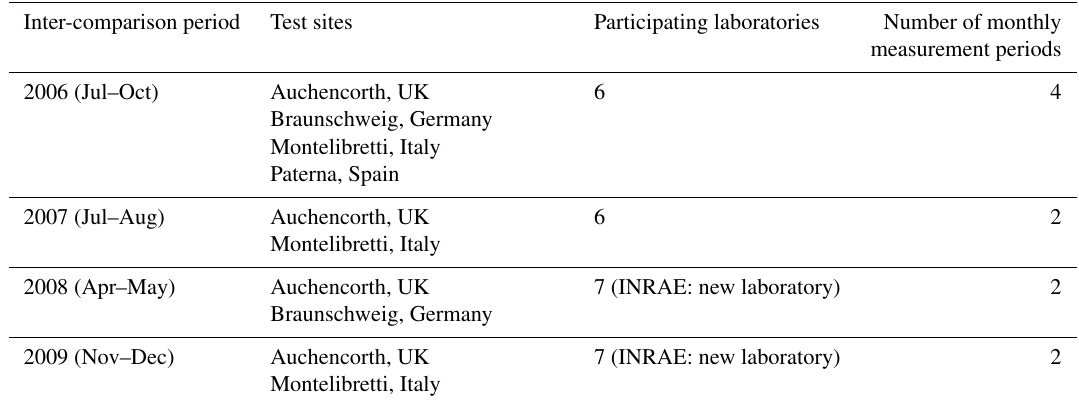
Table 1. Details of annual NitroEurope (NEU) DELTA ® field inter-comparisons conducted between 2006 and 2010. Inter-comparison period Test